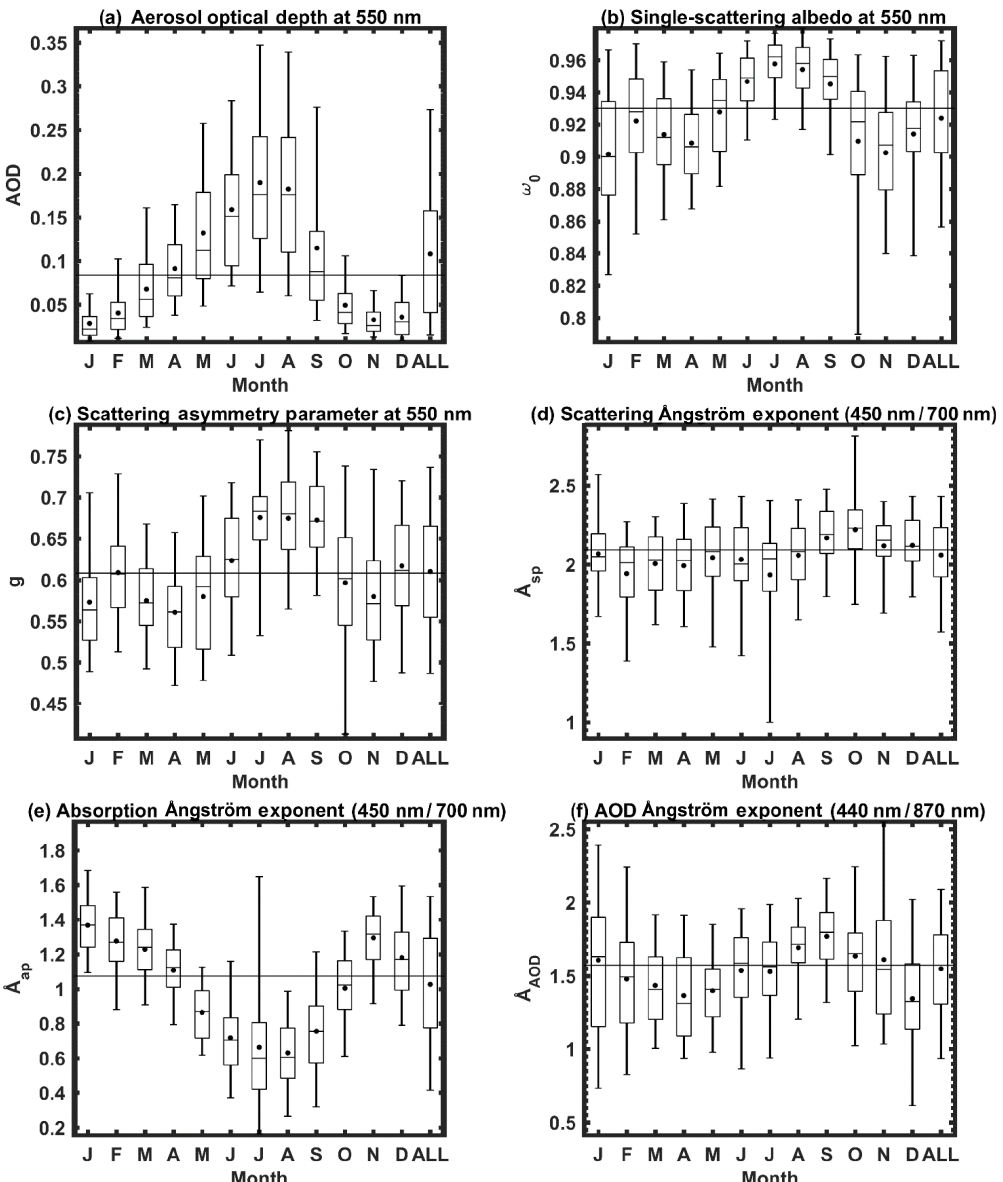
Figure 5. Boxplots of monthly binned aerosol optical properties at APP. The “ALL” box provides the statistics for all days in June 2012 to February 2016 period. The mean for each month is denoted by the dot while the horizontal bar represents the median. The top and bottom of the box represent 75th and 25th percentiles while the top and bottom whisker extend to the 95th and 5th percentiles, respectively. The horizontal line drawn through all boxes of each plot represents the median value over the entire period (all